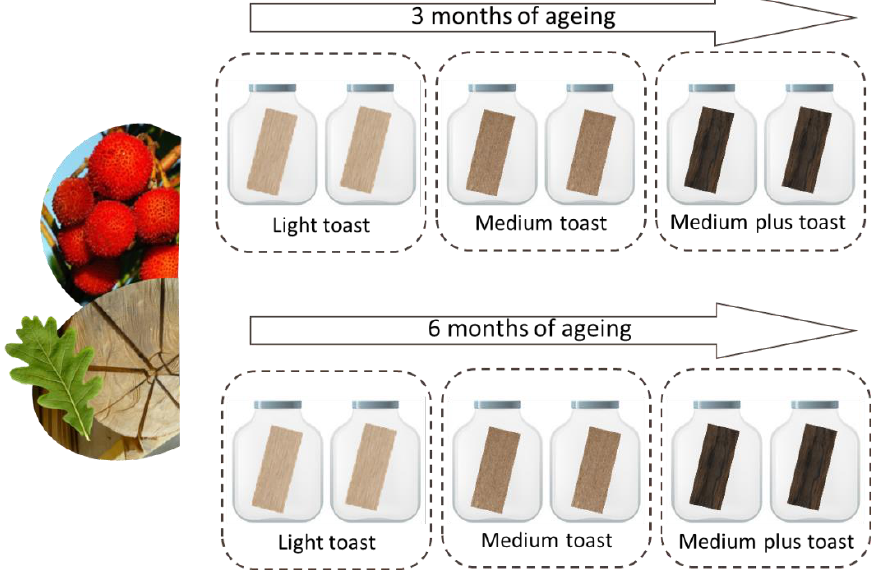
Figure 1. Scheme of the essay.